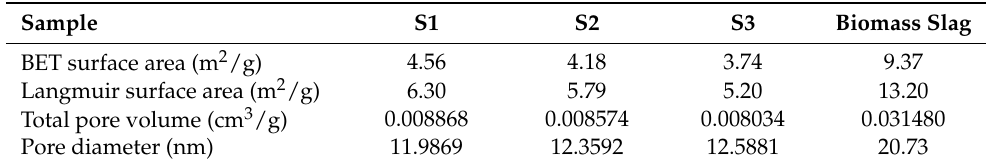
Figure 7. N 2 adsorption–desorption isotherms and pore size distribution diagrams of ( a ) Soil 1, ( b ) Soil 2, ( c ) Soil 3, and ( d ) OPBS. Table 5. BET specific surface area (SSA) and pore volumes of soil